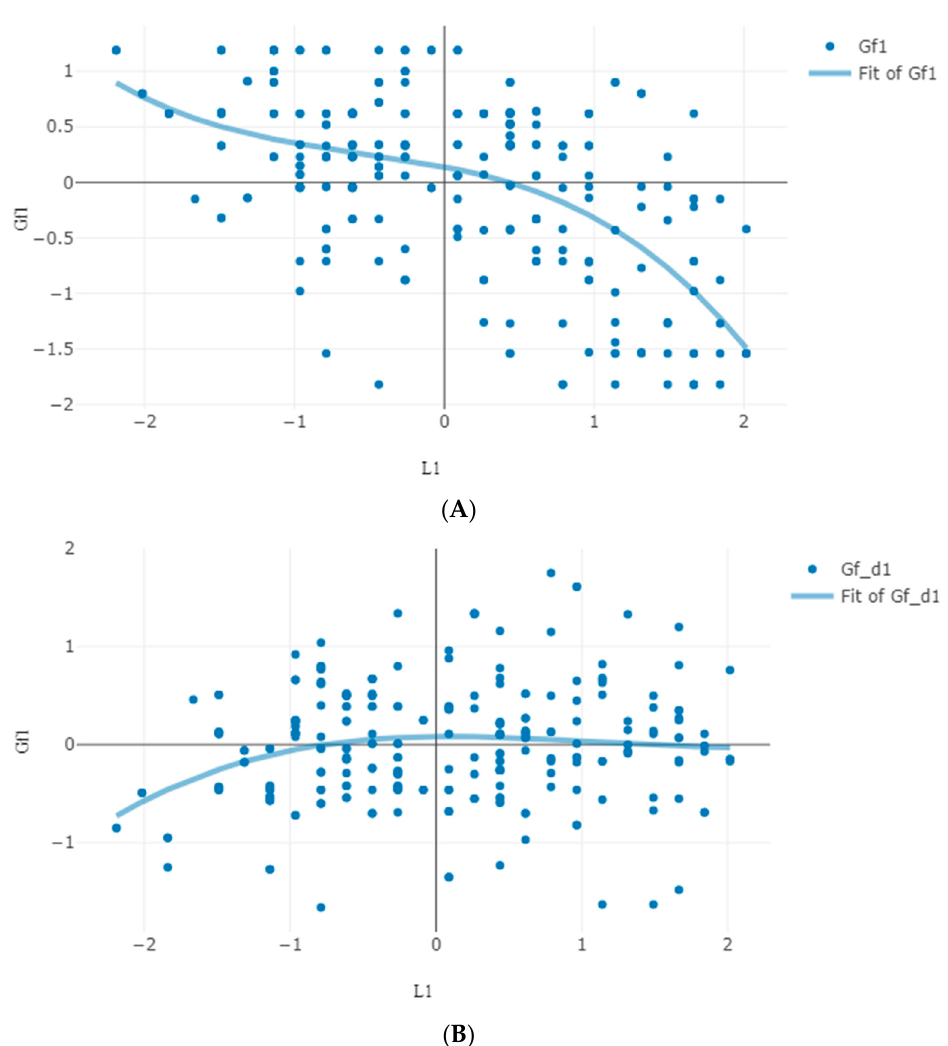
Figure 4. Relations between Gf and L (Panel A , R 2 = 0.39) and change in Gf from first to second testing wave with L (Panel B , R 2 = 0.07).